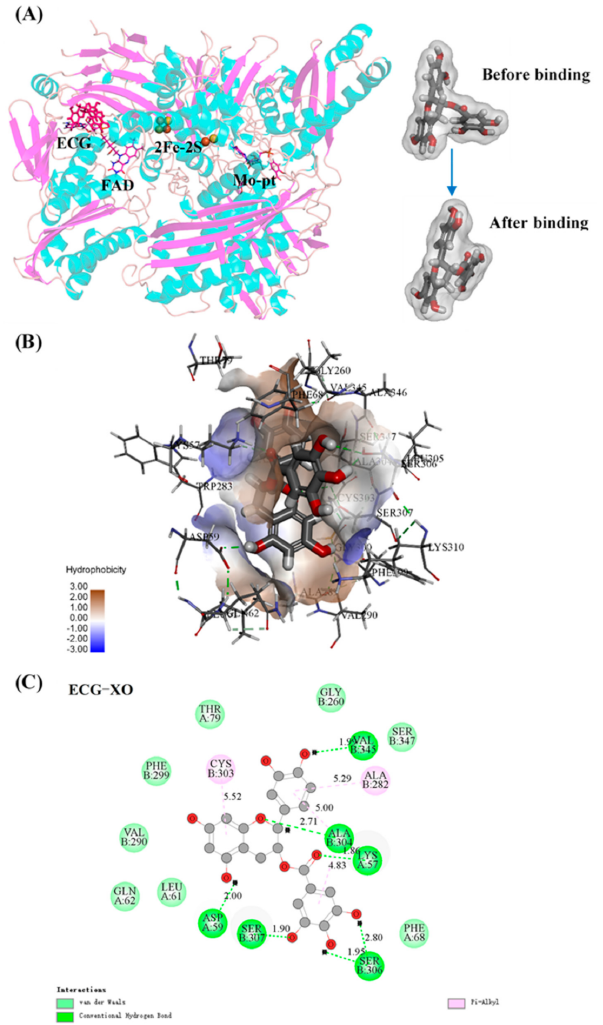
Figure 5. Molecular docking. ( A ) The docking model of ECG–XO complex. The left insets were 3D conformations of ECG before and after binding to XO; ( B ) the hydrophobicity surface of the binding area of ECG in XO; ( C ) the 2D schematic diagram of the binding between ECG and amino acid residues of